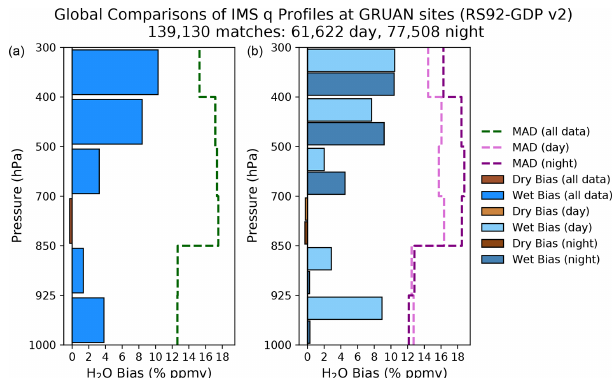
Figure 6. Comparisons of water vapour profiles from the IMS L2 product at GRUAN sites, matched at sites between 1 June 2007 and 31 December 2016 and with up to 80% cloud cover. Median biases for atmospheric layers are shown with blue bars representing a me- dian wet bias relative to GRUAN, while brown bars depict a median dry bias with respect to GRUAN. Panel (a) shows results for all data that pass quality control, with panel (b) showing the breakdown be- tween day and night results. All biases have been normalized by the median GRUAN layer value for the site and multiplied by 100 (i.e. to scale to %ppmv). Dashed lines represent each layer’s normalized median absolute deviation